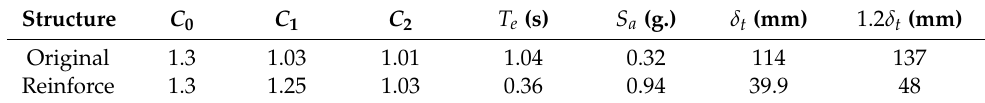
Table 4. Parameters of the target design story’s drift value ( 1.2 δ t ) .